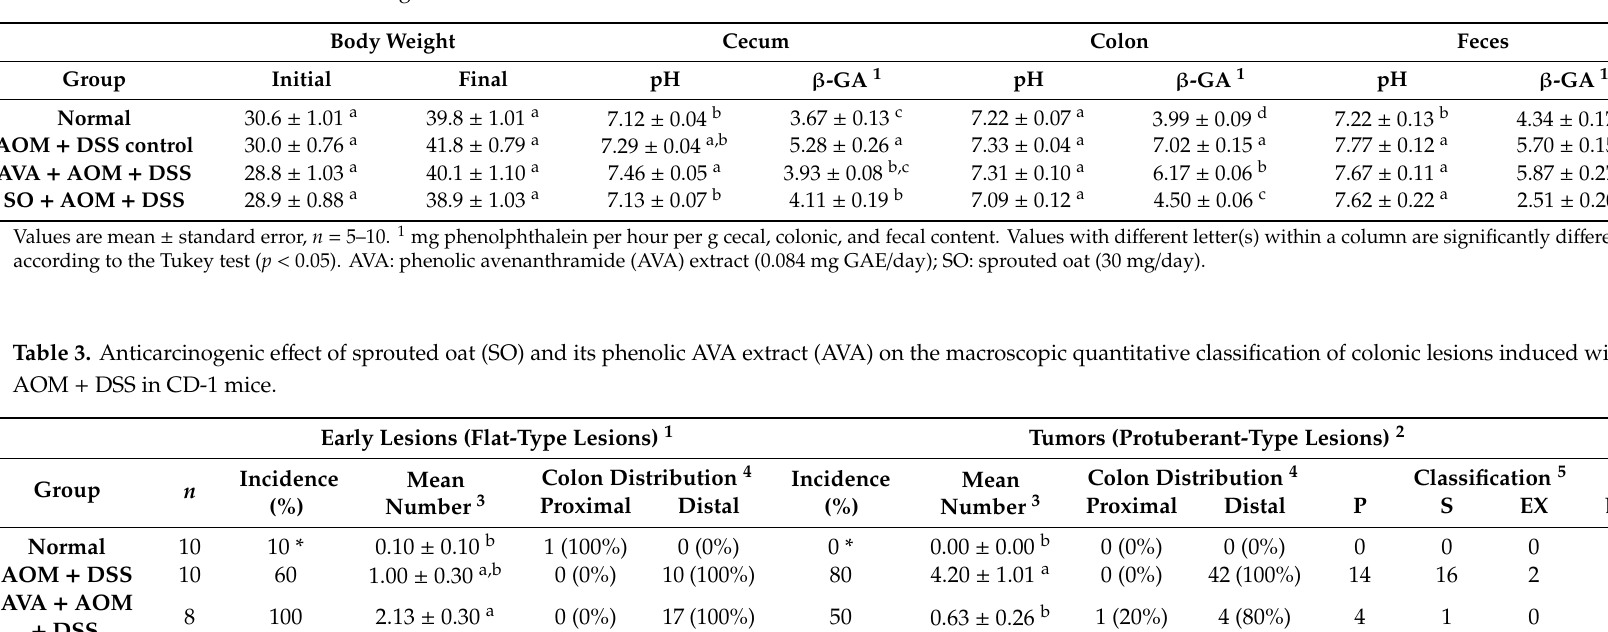
Table 2. Changes in body weight and cecal, colonic, and fecal measurements of CD-1 mice fed with sprouted oat (SO) and its phenolic AVA extract (AVA) at week 16 of the AOM + DSS-induced colon carcinogenesis.